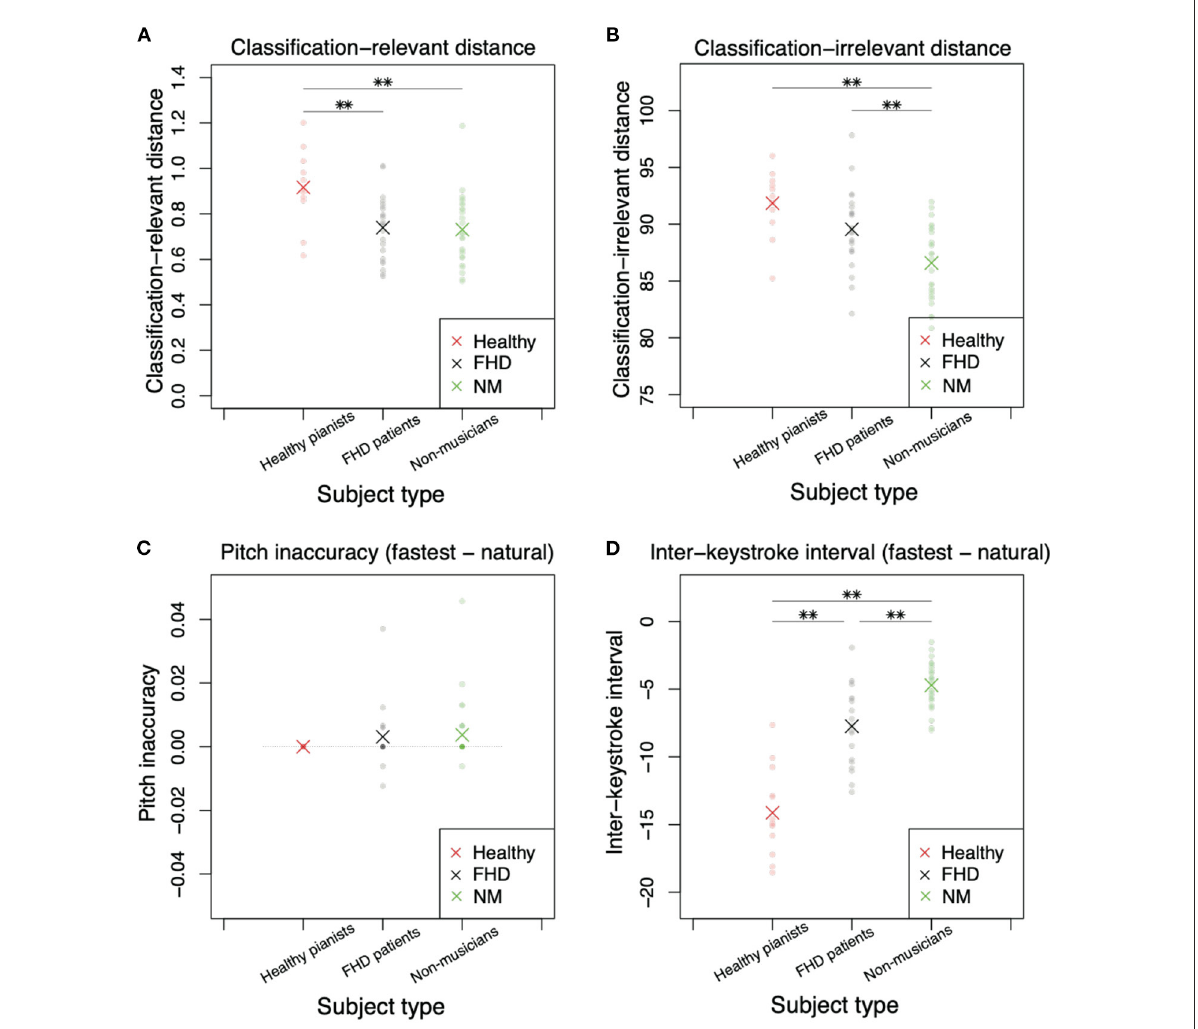
FIGURE5 Comparisons of classification-relevant distance, classification-irrelevant distance, pitch inaccuracy, and interkeystroke interval among healthy pianists, patients with FHD, and non-musicians based on the simplest piece (piece #1). (A) Classification-relevant distance among the three groups. Red, black, and green dots denote the distances in each subject. Asterisks indicate mean classification-relevant distances in each group. Double asterisks indicate significant differences based on p < 0.01. (B) Classification-irrelevant distance. (C) Pitch inaccuracy in playing at the natural tempo subtracted from the inaccuracy in playing at the fastest tempo. (D) Interkeystroke interval in playing at the natural tempo subtracted from the inaccuracy in playing at the fastest